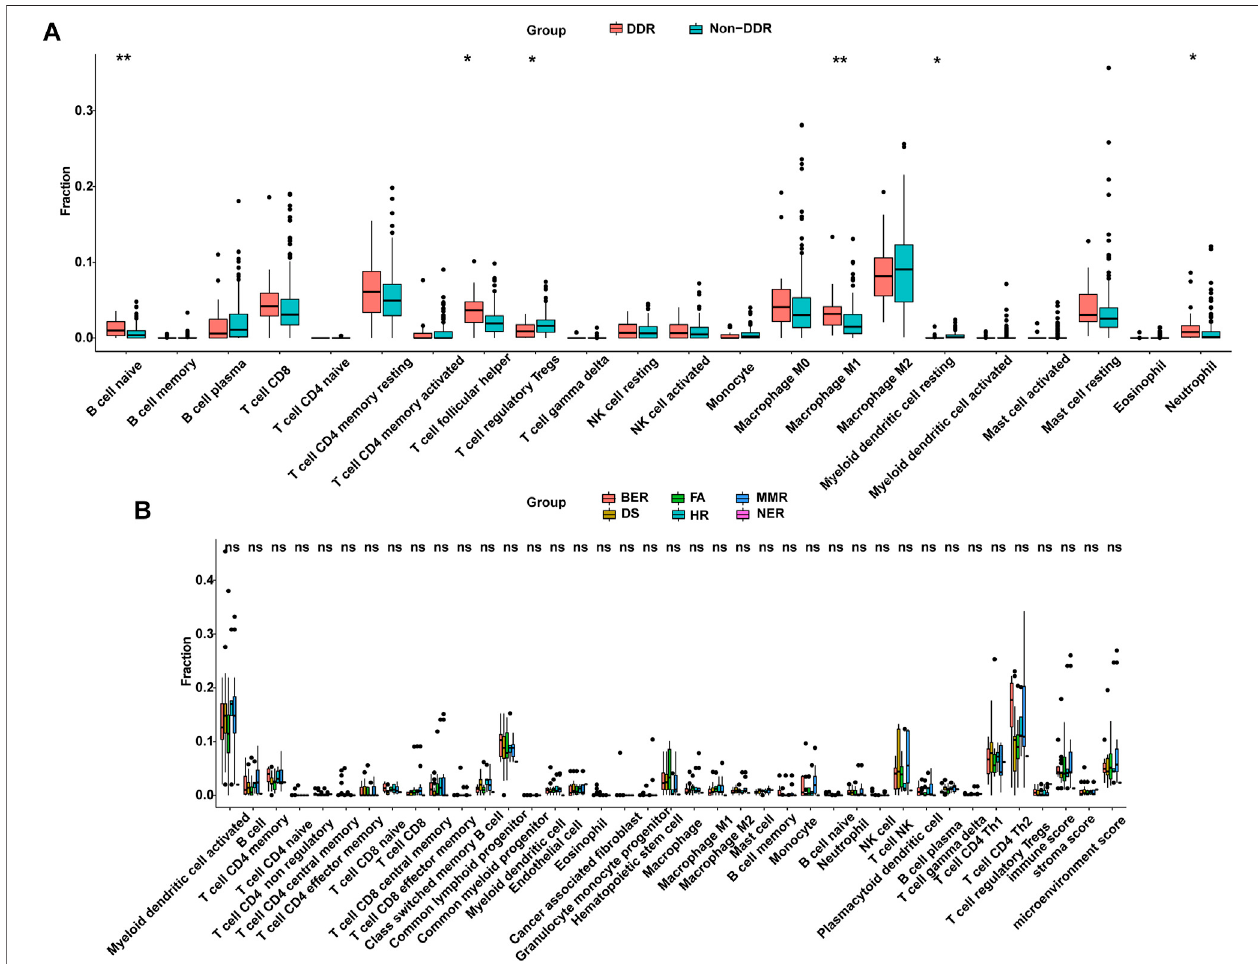
FIGURE 8 | DDR was correlated with the in fi ltration of immune cells from the TCGA cohort. (A) Differentially in fi ltrated immune cells between DDR and non-DDR groups. (B) Comparison of in fi ltrated immune cells in different altered DDR pathways. DDR: DNA damage response; TCGA: The Cancer Genome Atlas.